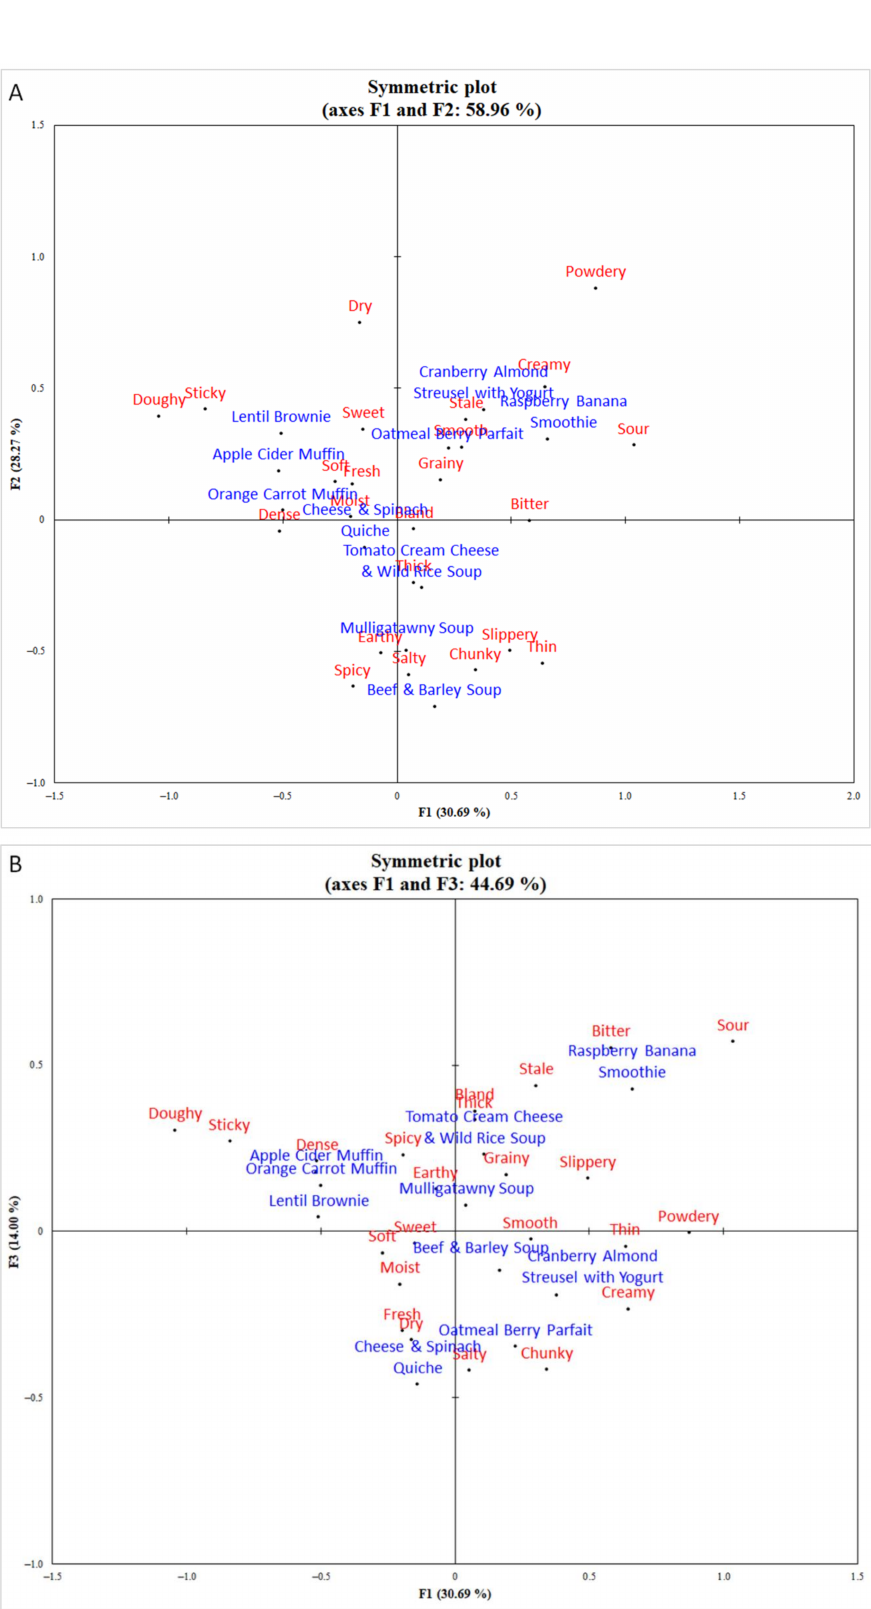
Figure 1. Symmetric plot derived from check-all-that-apply (CATA) responses of ten nutrient-dense foods during sensory evaluation without nutrition and health information. ( A ) Factors 1 and 2 explained 59.0% of the variability. ( B ) Factors 1 and 3 explained 45.0% of the